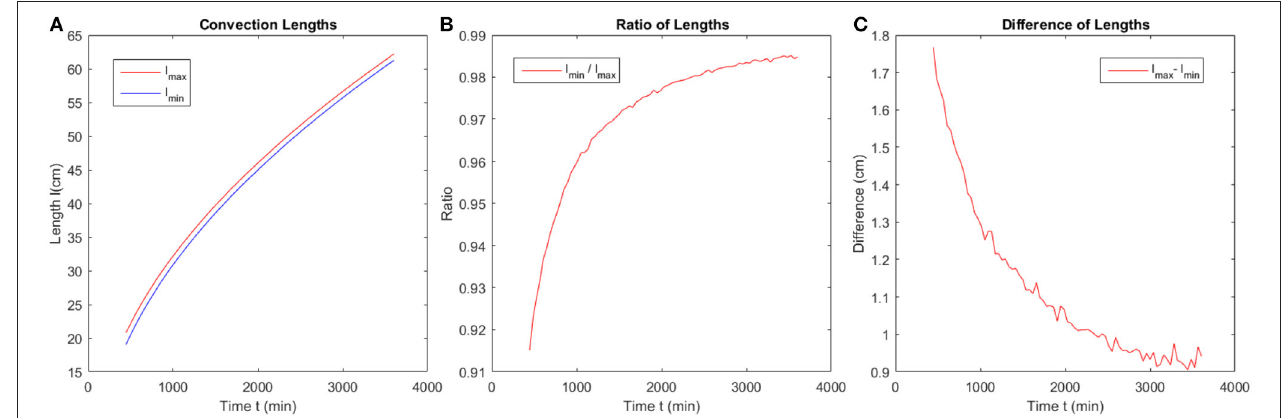
FIGURE 11 | Evolution of characteristic length scales in the system with time. (A) The maximum and minimum convection length evolution with time. (B) The ratio of the two lengths shown in (A) , which approaches unity at long times. (C) The difference of the two lengths shown in (A) , which approaches zero at long times.